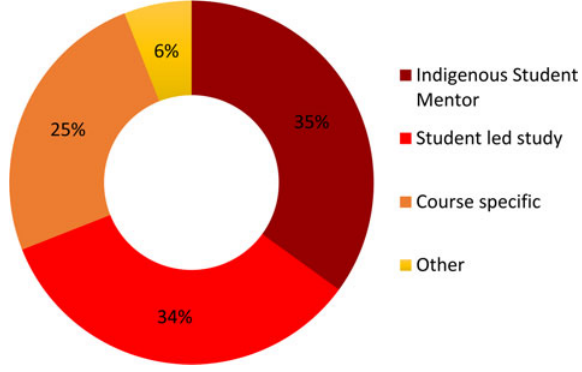
Fig. 11. Use of services provided by faculty.